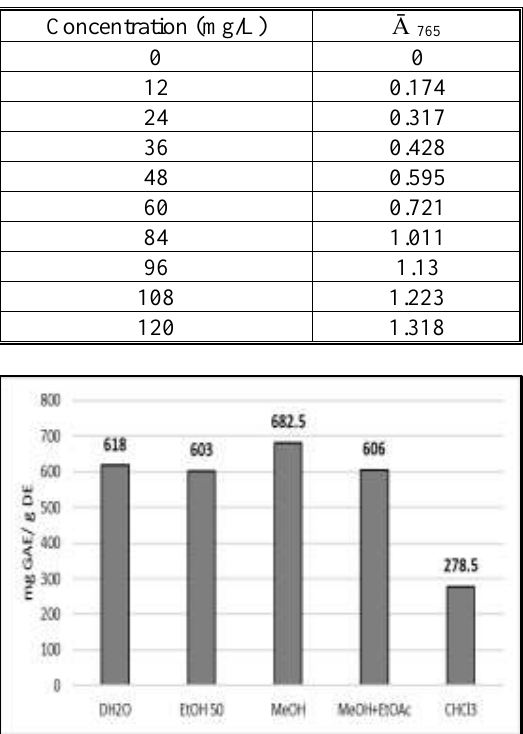
Table 3. Gallic acid concentrations and their absorbances